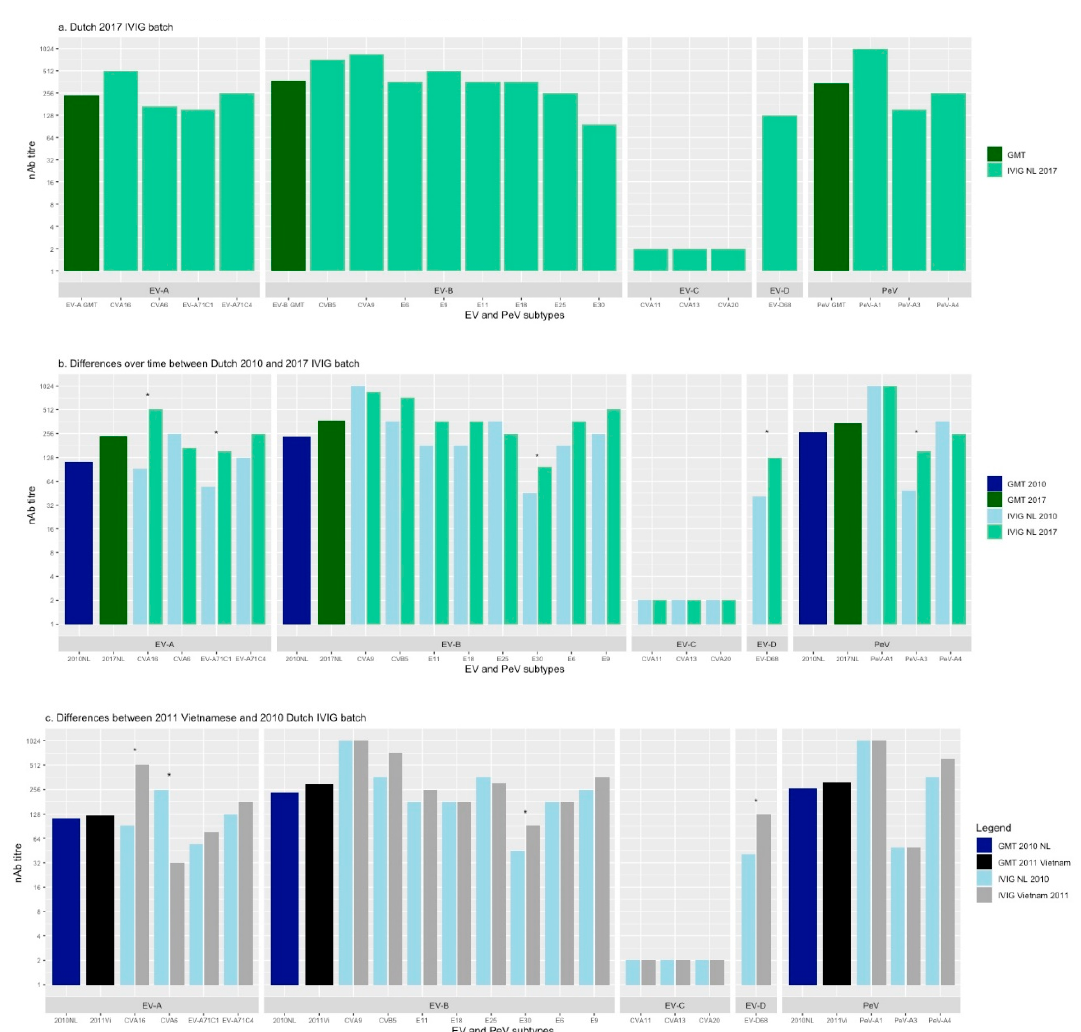
Figure 1. Neutralising antibody titres against different Entero- and Parechovirus strains a . Dutch 2017 IVIG batch b . Differences over time between Dutch 2010 and 2017 IVIG batch c . Differences between 2011 Vietnamese and 2010 Dutch IVIG batch. Asterisks (*) indicate a more than twofold difference in nAb titre between IVIG batches. GMT; geometric mean titre, IVIG; intravenous immunoglobulins, nAb titre; neutralising antibody titre, EV; enterovirus, PeV; parechovirus, CVA; coxsackievirus A, CVB; coxsackievirus B, E; echovirus, NL; the Netherlands, Vi; Vietnam.